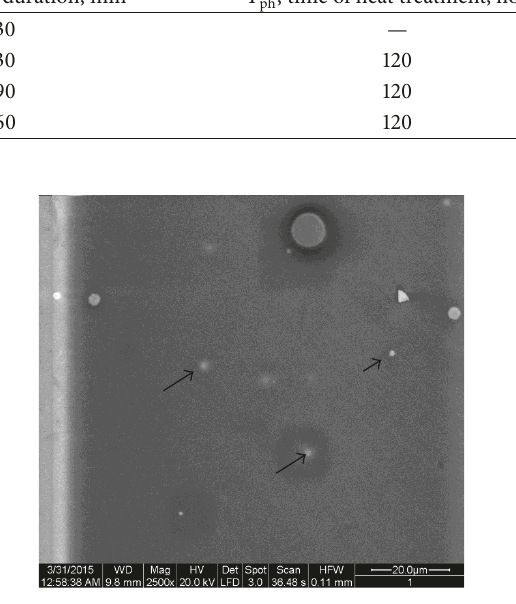
Figure 1: SEM image for S1